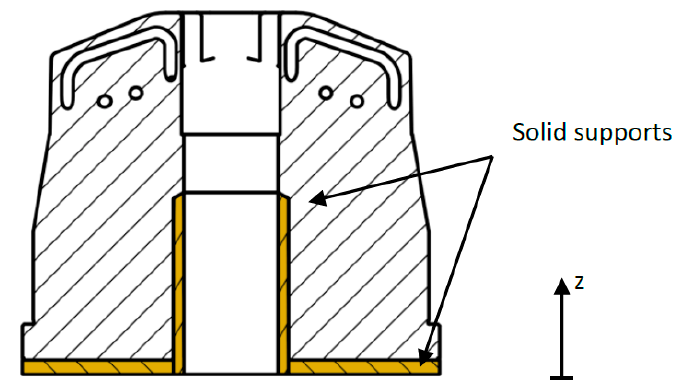
Figure 19. Sketch of the injection molding tool on the build platform of the PBF system.